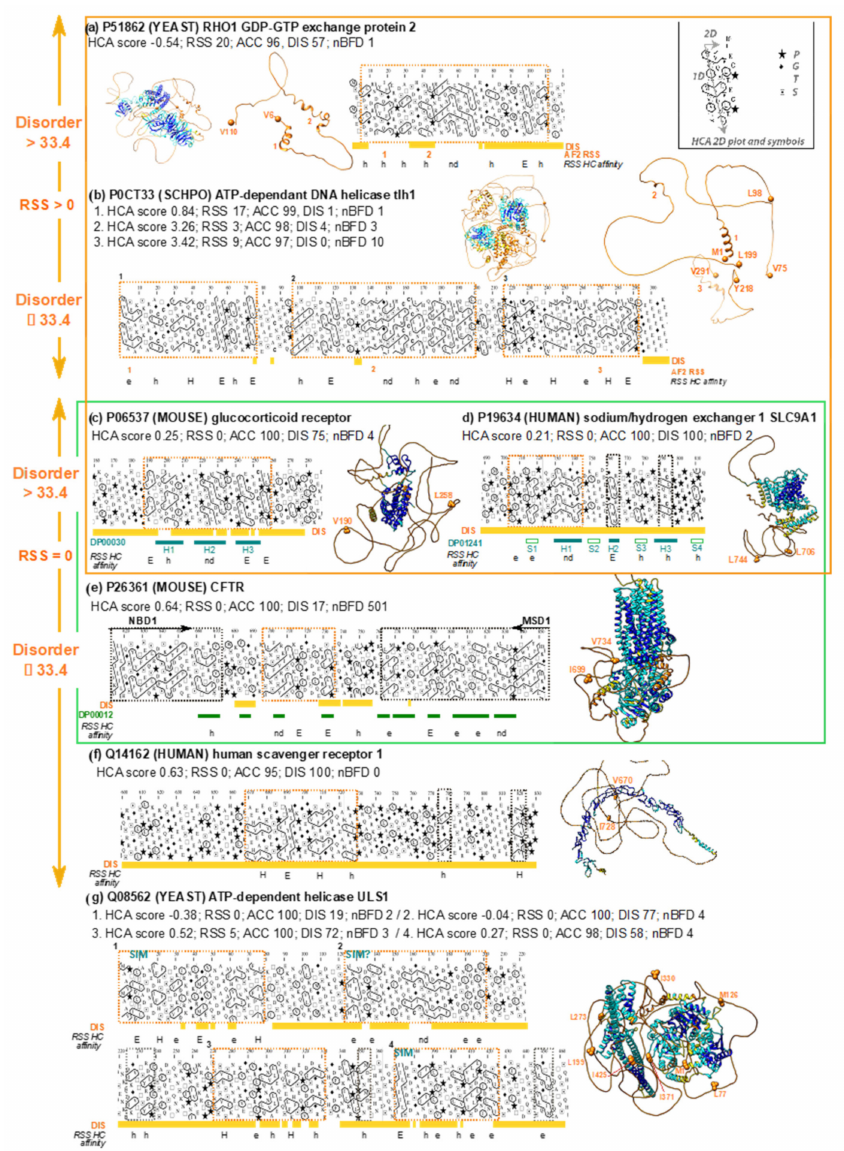
Figure 8. Examples of full-VL soluble-like foldable segments corresponding to unfolded AF2 predic- tions. See legend in Figure 7. The green box illustrates cases of disordered sequences with transient regular structures (highlighted in green below the HCA plot), documented in the DisProt database (accession number in green at left). SIM stands for Sumo-Interacting Motif. Orange boxes correspond to sequences included in the most populated leaf of the full-VL tree shown in Figure 5. Subfigures a and b correspond to examples with RSS coverage (predicted by AF2) > 0 and disorder coverage (IUPred2 predictions) > 33.4 ( a ) and ≤ 33.4 ( b ). Subfigures c to f correspond to examples RSS